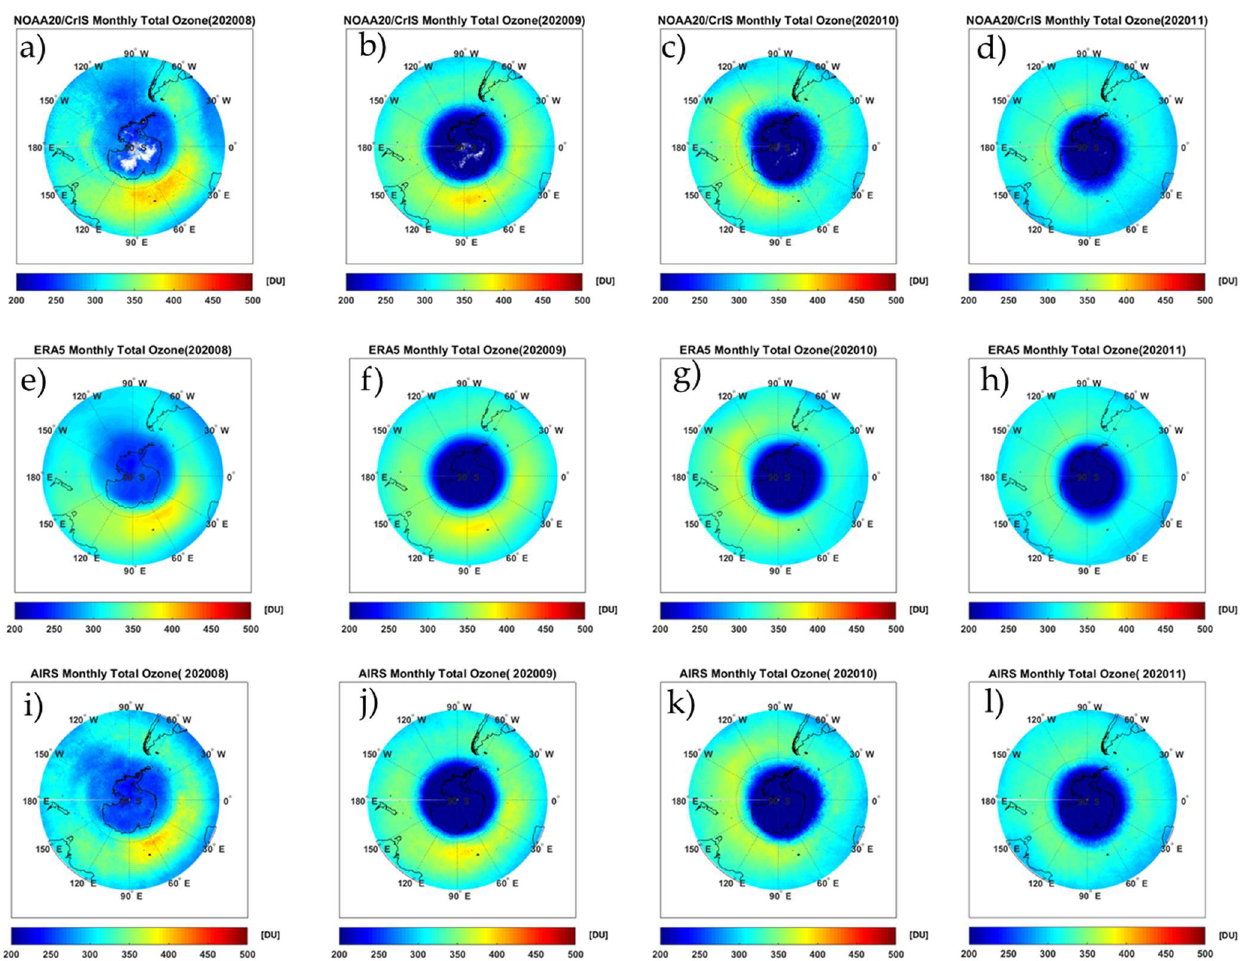
Figure 3. Similar to Figure 2, but in the high latitudes of the southern hemisphere in August–November 2020. August: ( a , e , i ); September: ( b , f , j ); October: ( c , g , k ); December: ( d , h , l ).